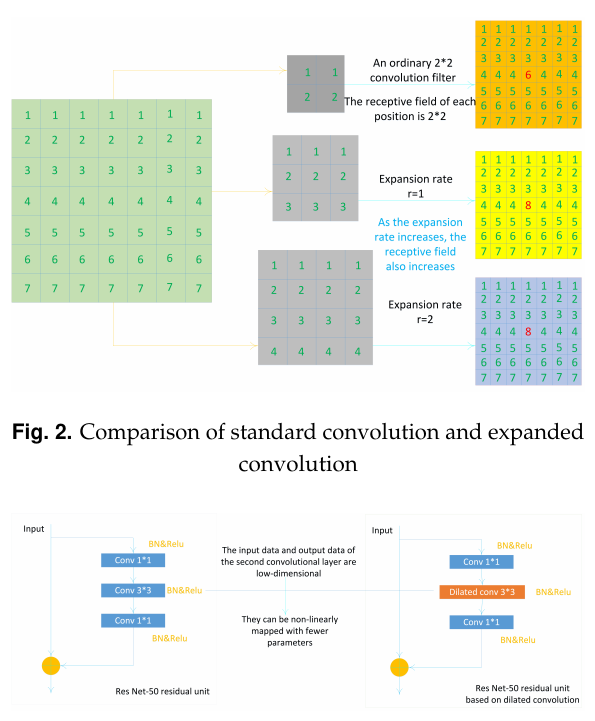
Fig. 3. Improved residual